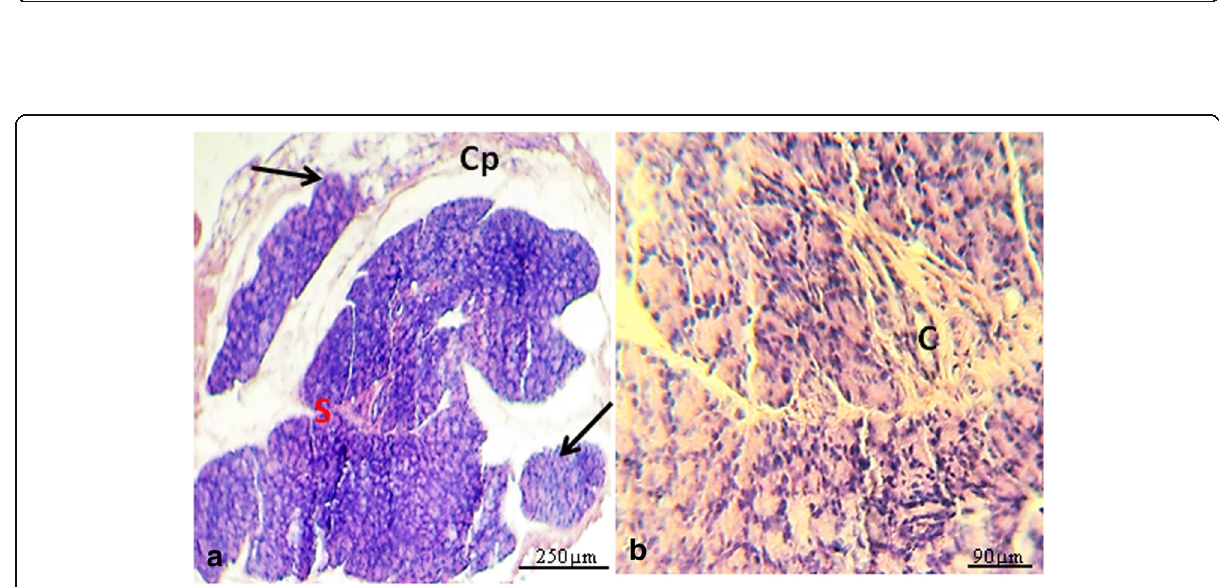
Fig. 3 a The gerbil lacrimal gland covered by a capsule (Cp) composed mainly of dense collagenous connective. The connective tissue septa (S) divide the gland into lobes and lobules (arrow). H/E stain. b Higher magnification of acini endpieces with central canal (C). H/E